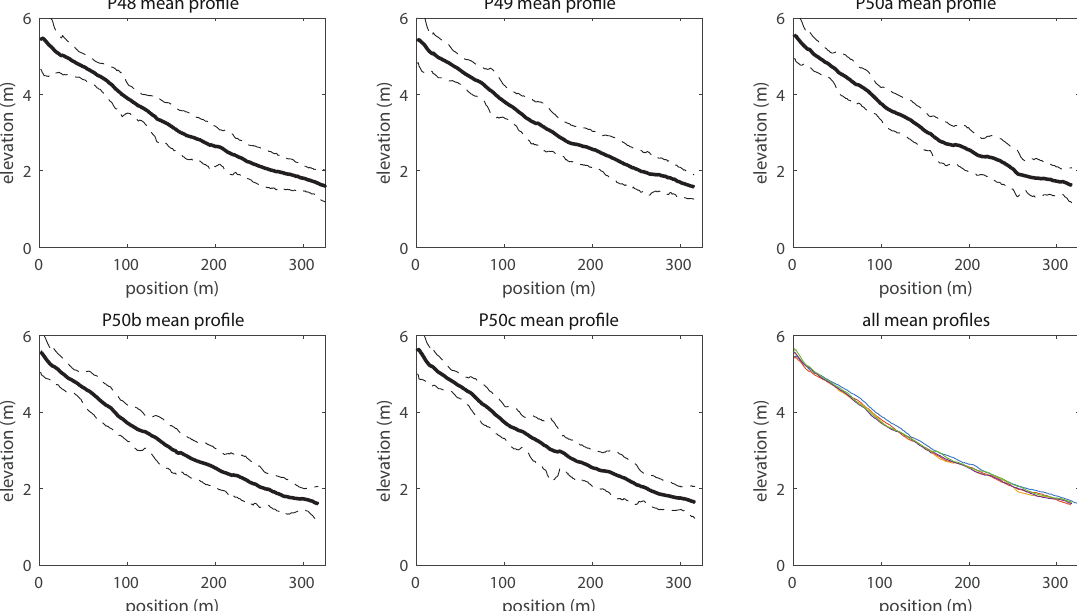
Figure 5. Average Coastal Division profiles as computed from a weighted mean of the elevation measured at 54 dates (plain line), along with the standard deviation of the measurements (dashed line). The last figure shows all average profiles as superimposed for comparison